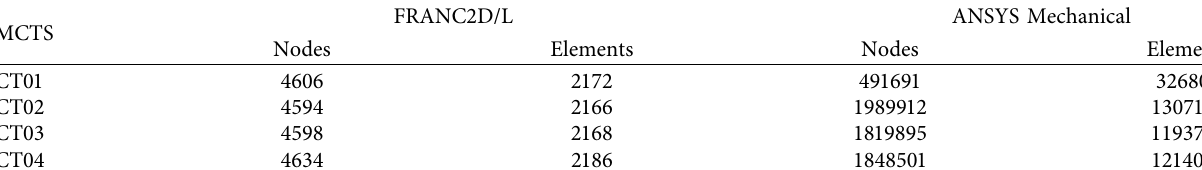
Table 2: Number of nodes and elements of the specimens in FRANC2D/L and ANSYS APDL 19.2.